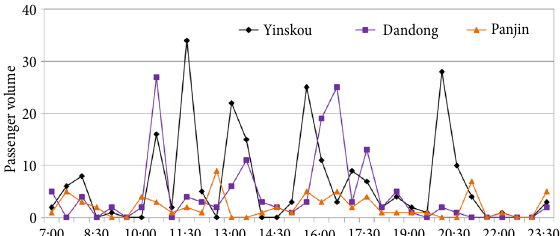
Fig. 7. The passengers’ flight departure time distribution in a single